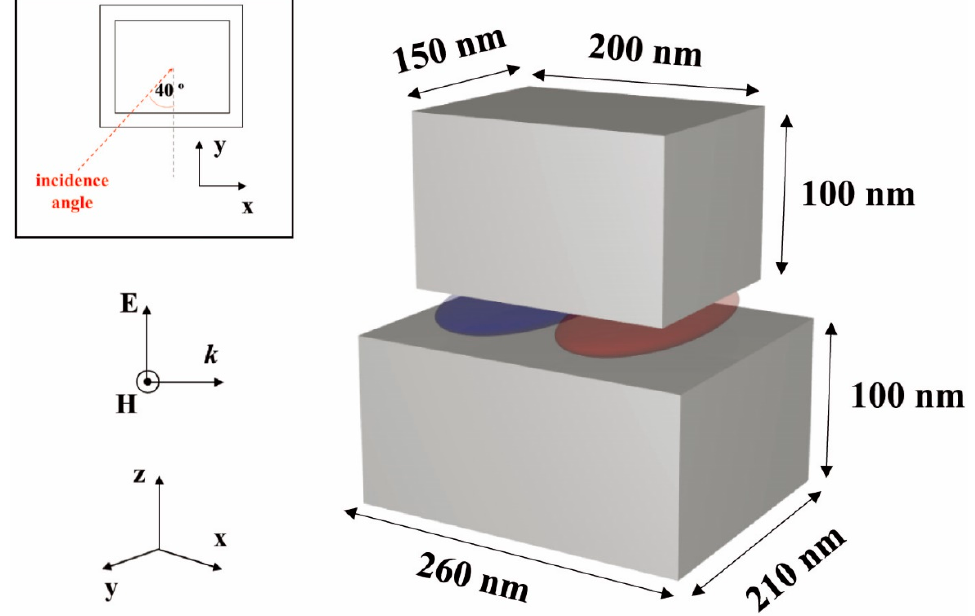
Figure 1. A schematic diagram of a 2D plasmonic ruler. The proposed ruler is made of two silver nanoblocks, a small upper block (200 nm × 150 nm × 100 nm) and a larger lower block (260 nm × 210 nm × 100 nm). Incident light with E z linear polarization is on the x – y plane and has an incident angle of 40 ° from the y -axis.